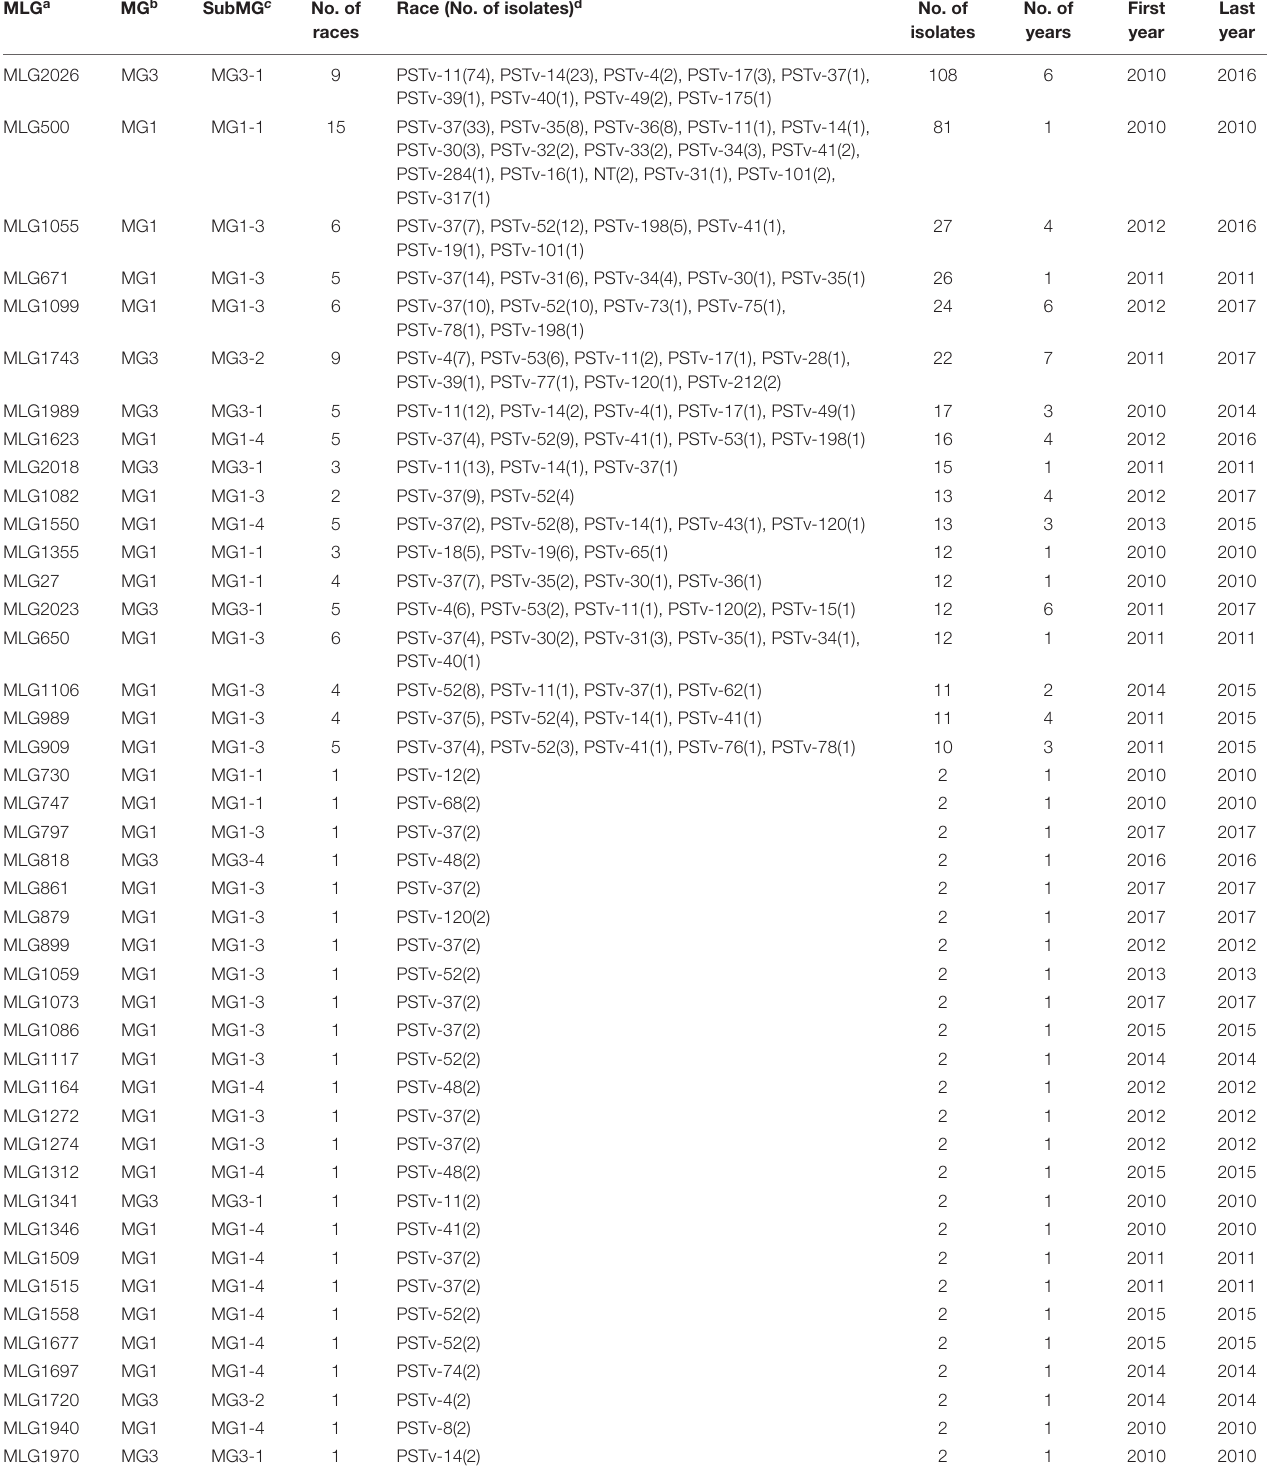
TABLE 9 | Races in major multilocus genotypes (MLGs) of Puccinia striiformis f. sp. tritici and number of isolates, number of years, and first and last year of detection for each of the MLGs. MLG a MG b SubMG c No. of